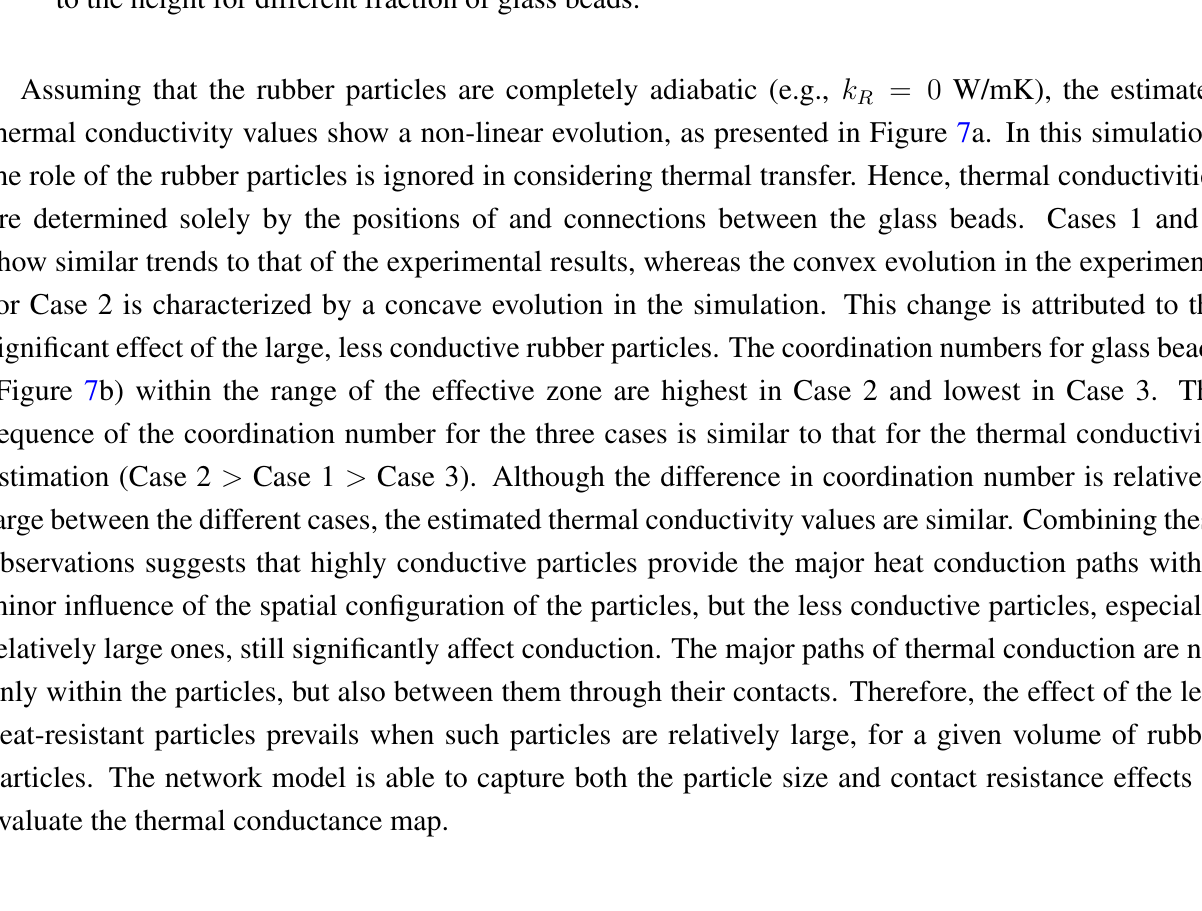
Figure 6. ( a ) Temperature distribution with respect to the height for F at steady-state condition; ( b ) profiles of estimated thermal conductivity values with respect to the height for different fraction of glass